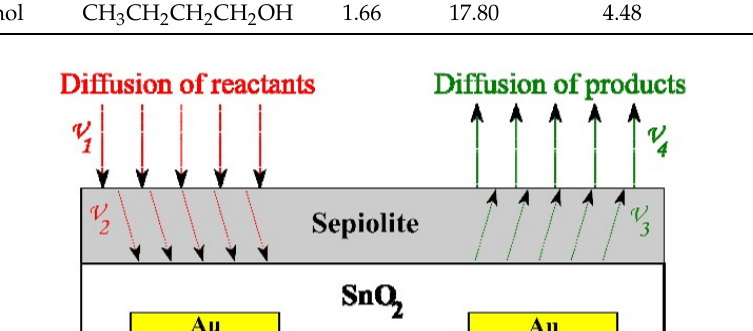
Figure 13. Diffusion of reactants and products to/from the SnO 2 sensor with the sepiolite